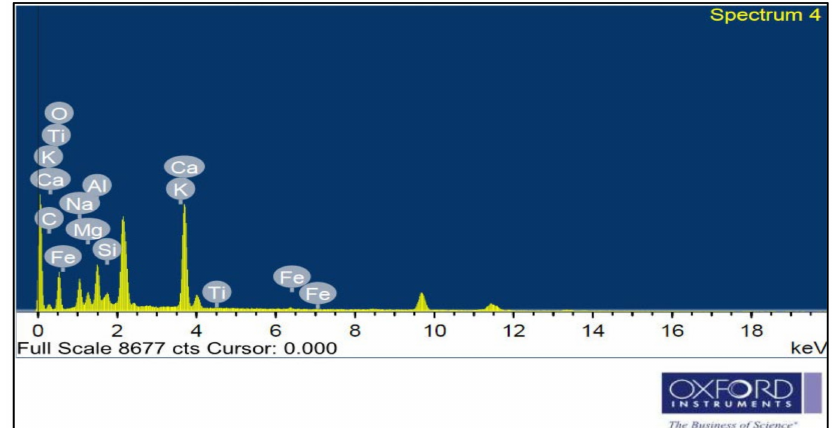
Figure 26. EDX analysis for mix Z1 under 500 ◦ C fire exposure at 180 days.